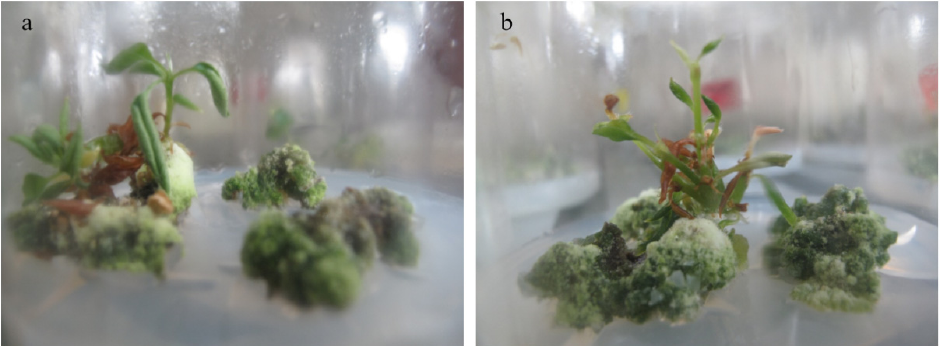
Figure 2. Shoots induced from calli in Cotoneaster wilsonii : ( a ) treatment with 0 mg · L − 1 TDZ and 1.0 mg · L − 1 BA; and ( b ) treatment with 1.0 mg · L − 1 TDZ and 0 mg · L − 1